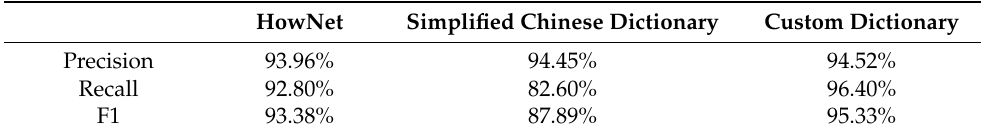
Table 1. Accuracy comparisons for sentiment